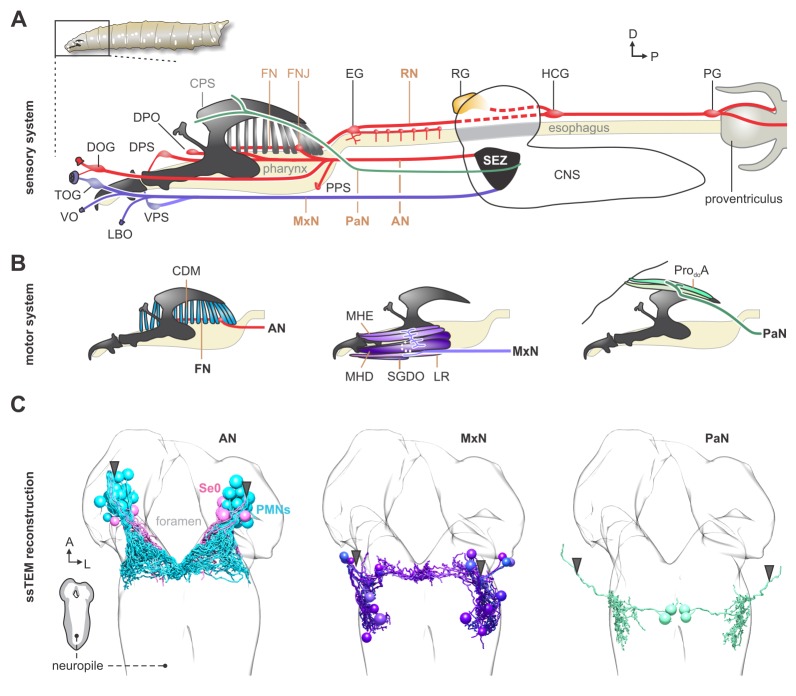
Anatomy of the pharyngeal nerves.(A) The cephalic, pharyngeal and enteric sensory system of the larval head (lateral view). Sensory neurons of the dorsal organ ganglion (DOG), dorsal pharyngeal sensilla (DPS), dorsal pharyngeal organ (DPO) and posterior pharyngeal sensilla (PPS) project to the subesophageal zone (SEZ) via the antennal nerve (AN). Sensory neurons of the enteric nervous system, including the frontal nerve (FN) and recurrent nerve (RN), esophageal ganglion (EG), hypocerebral ganglion (HCG) and proventricular ganglion (PG), fuse together with the AN shortly after the frontal nerve junction (FNJ). The terminal organ ganglion (TOG), ventral organ (VO), labial organ (LBO) and ventral pharyngeal sensilla (VPS) project to the SEZ via the maxillary nerve (MxN). The prothoracic accessory nerve (PaN) contains sensory pathways from dorsal head region and enters the brain between the tritocerebrum and ventral ganglion. (B) Feeding related muscle system. The motor neurons of the antennal nerve (PMNs) innervate the cibarial dilator muscles (CDM) through the frontal nerve. The mouth hook elevator (MHE), mouth hook depressor (MHD), salivary gland ductus opener (SGDO) and labial retractor (LR) are innervated by side branches of the maxillary nerve. The dorsal protractor (ProdoA) is innervated by the prothoracic accessory nerve. (C) EM reconstruction of all motor neurons innervating the feeding related muscles in the larval head. Arrowheads mark respective nerve entry site.